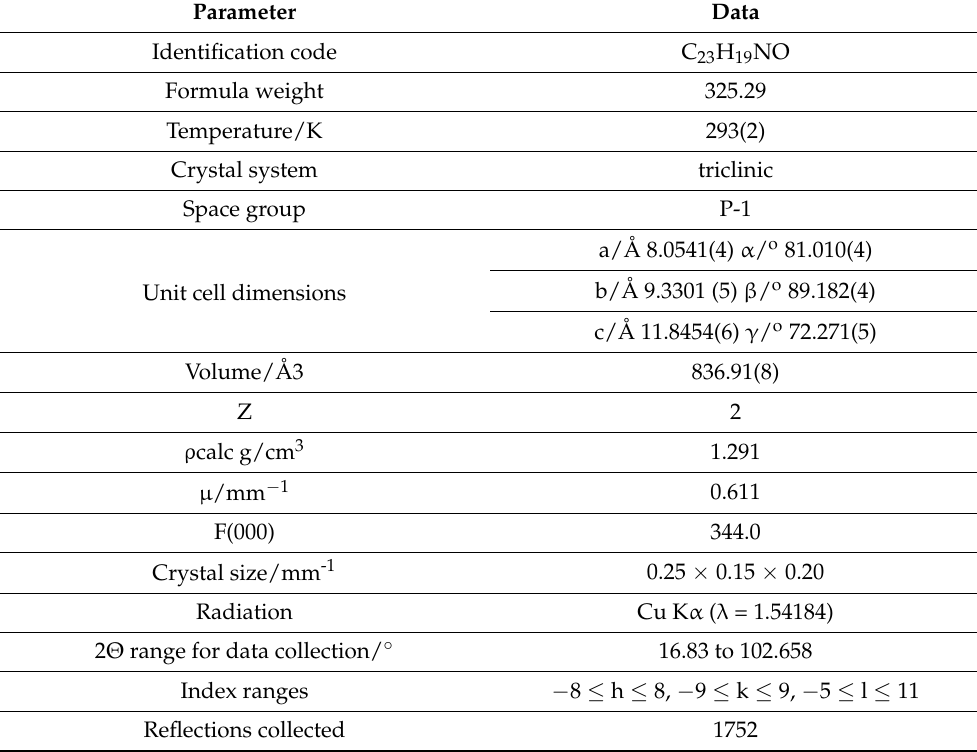
Table 1. Summary of the crystallographic data and refinement statistics for 15